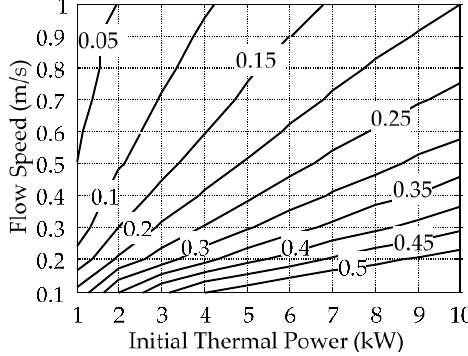
Figure 16. Rate at different flow speed and initial thermal power value.